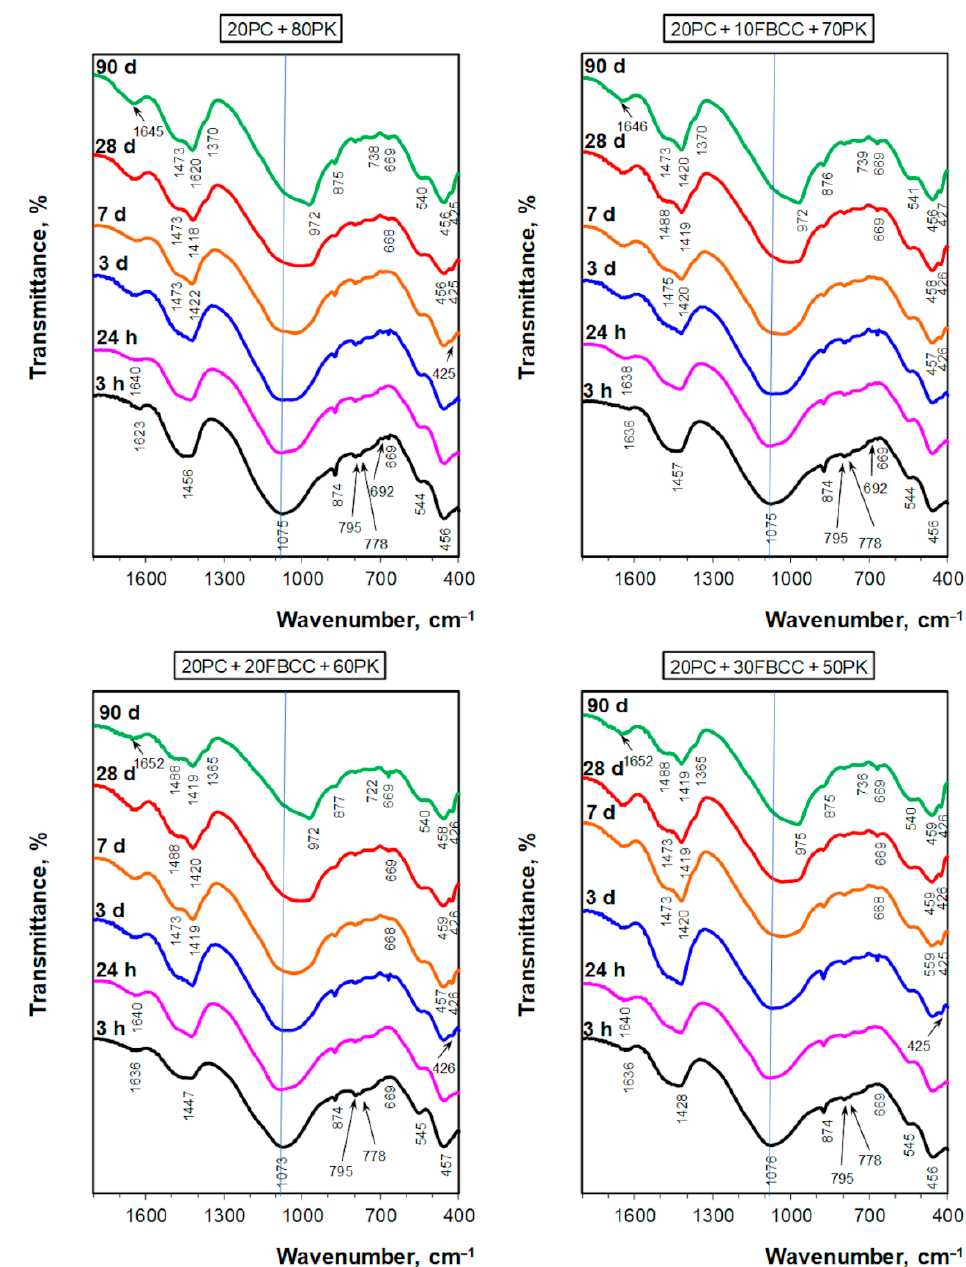
Figure 11. IR spectra for blended four-component binders after different times of hydration (at wavenumber scale from 400 to 1800 cm − 1 ).